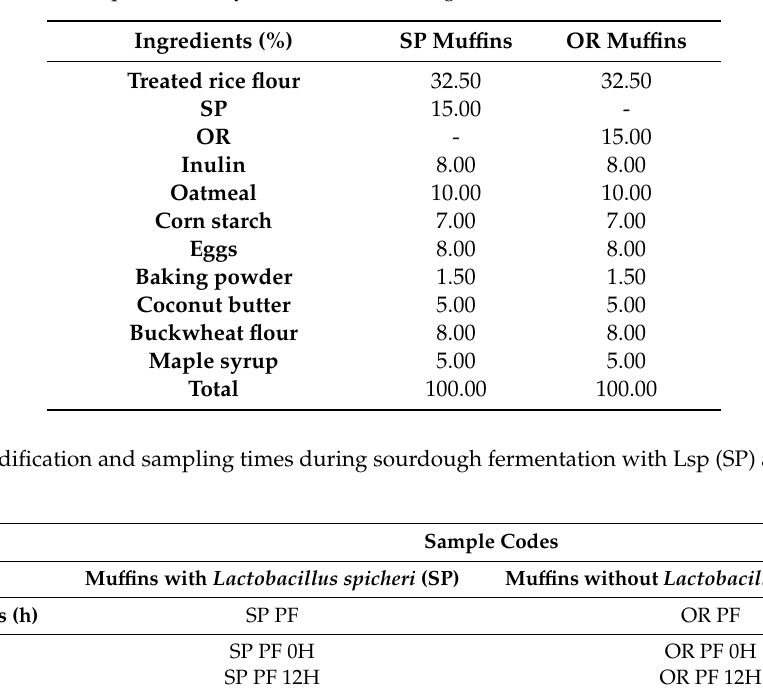
Table 3. Formulations for gluten-free mu ffi ns with sourdough fermented with Lactobacilus spicheri DSM 15429 strain and with spontaneously fermented sourdough (OR).